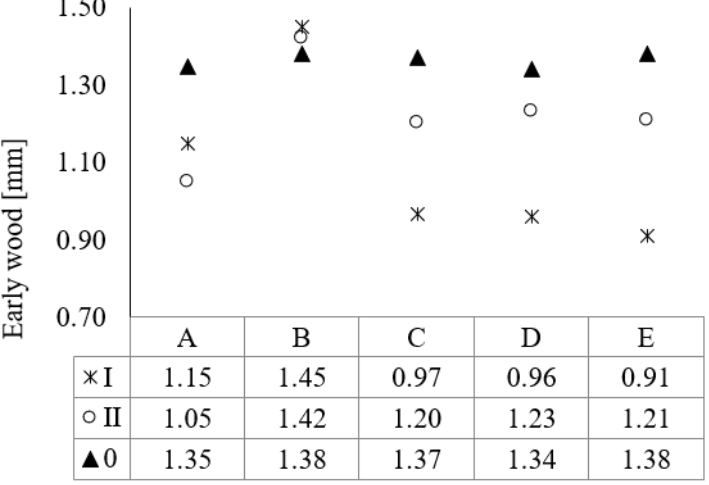
Figure 3. Increment variability on the thickness of earlywood depending on the pruning variant and